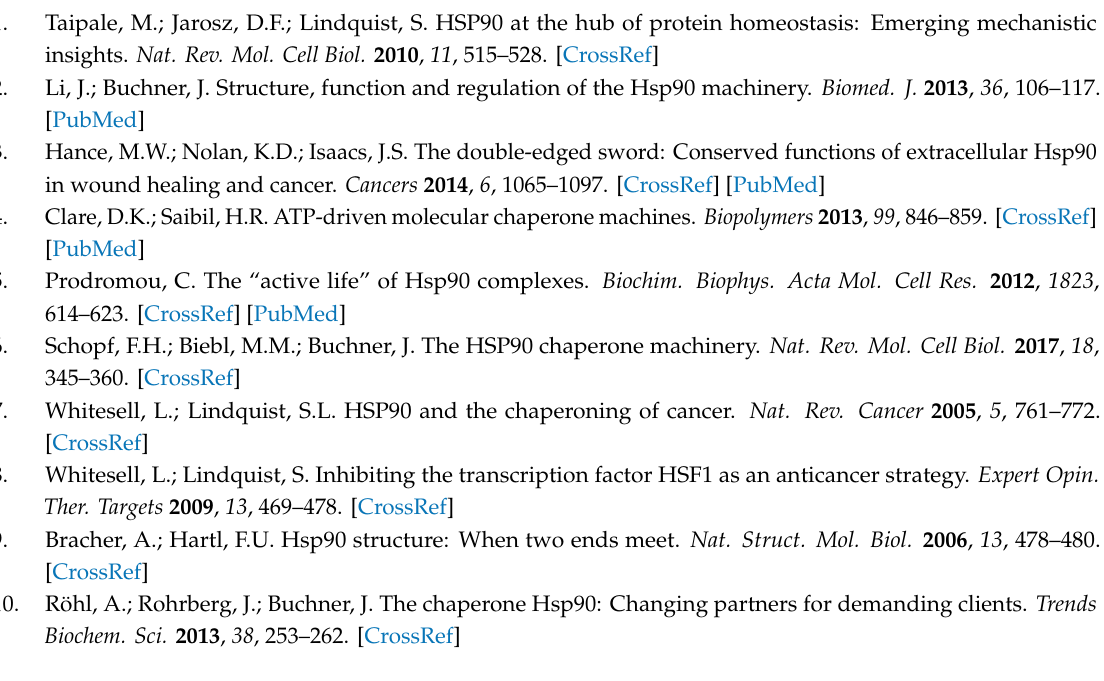
Figure S1: Colocalization of FN fragments with the Golgi apparatus, Figure S2: Confirmation of expression of proteins from BiFC plasmids; Table S1: Primer sequences used to generate expression plasmids used in this study, Table S2: PCR parameters used in this study, Table S3: Key resources used in this study and supplementary methods for protein expression and